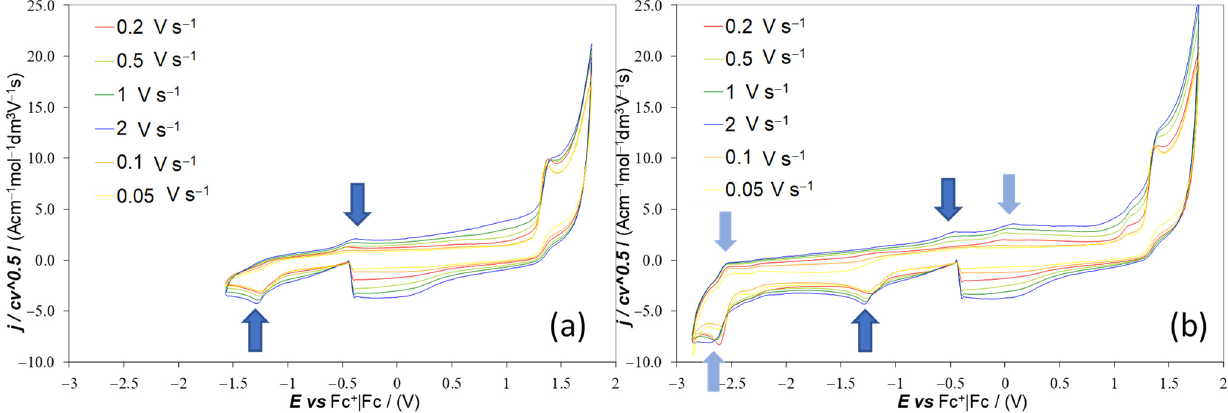
Figure 4. Highlighted return oxidation processes related to the first ( a ) and second ( b ) reduction processes for compound 2 . Arrows of same colour indicate correlated peaks.